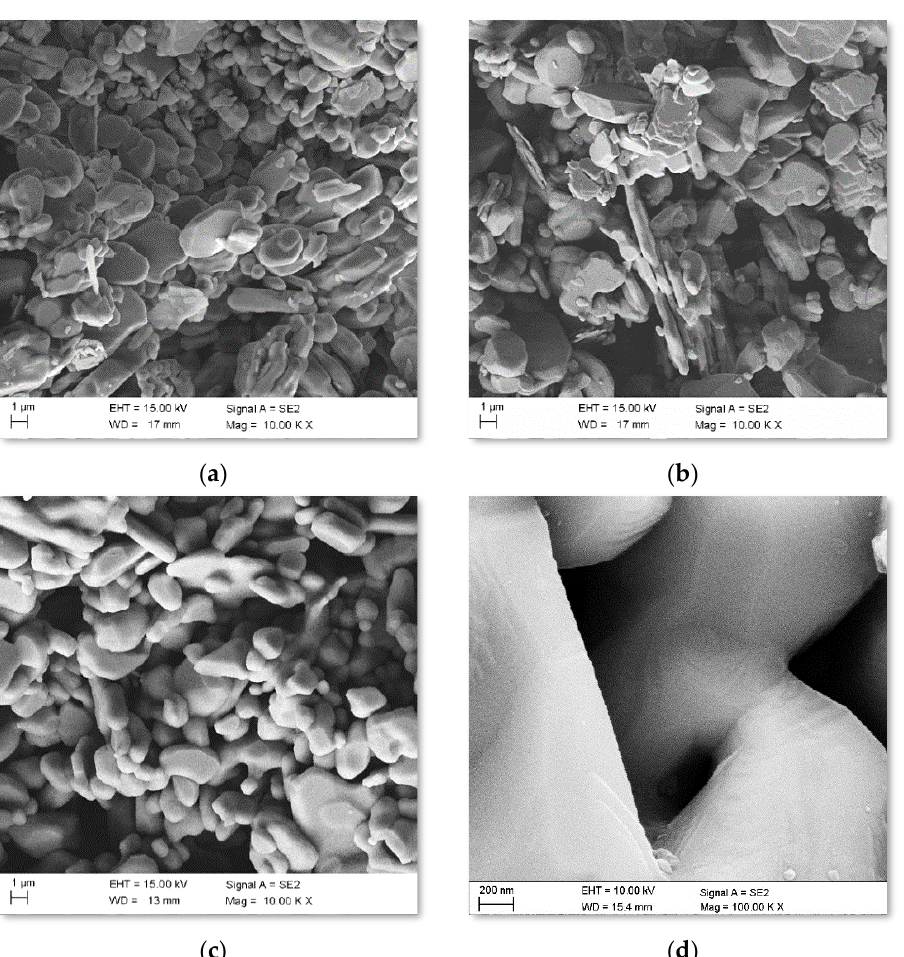
Figure 2. SEM images of fractures in porous ceramic skeletons sintered at ( a ) 1200 °C, ( b ) 1400 °C, and ( c , d ) 1600 °C.